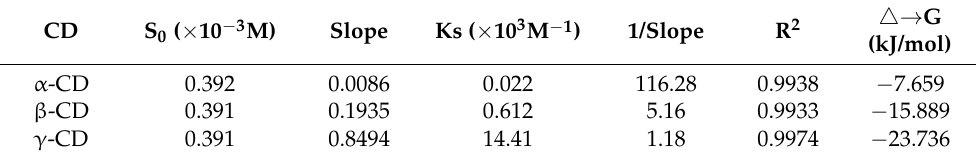
Figure 2. Phase solubility curves of G-Re in CDs: “1” is for α -CD; “2” is for β -CD; “3” is for γ - CD. Phase solubility curves of G-Re with different CDs α -CD, β -CD, and γ -CD were labeled 1, 2 and 3, respectively. Table 1. Phase solubility parameters of G-Re in different CDs in water.